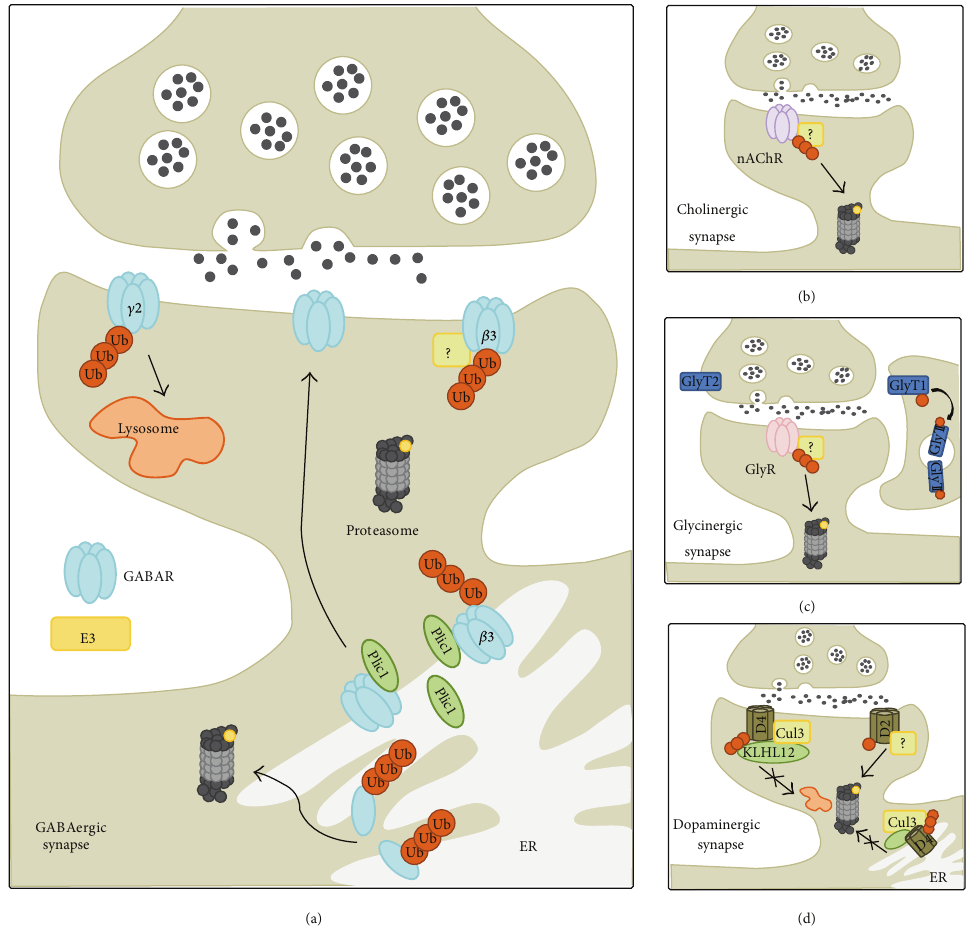
Figure 4: (a) GABAergic ubiquitination. The specific E3 ligase for GABARs has not been identified, although the ubiquitin-like protein Plic- 1, which does not function for ubiquitination, directly interacts with GABA A Rs to affect insertion. It stabilizes polyubiquitinated GABA A Rs in the ER to limit ERAD and promote GABA A R surface expression. Unassembled GABAR subunits in the ER are usually ubiquitinated and targeted to the proteasome. Although the proteasome plays a large role in GABA A R trafficking, the lysosome also mediates GABA A R degradation by ubiquitinating a motif in intracellular domain of the 𝛾 2 subunit. (b) Cholinergic synapses. In the cholinergic synapse, the E3 ligases remain unidentified although it is known that ubiquitination of the 𝛼 3, 𝛽 2, and 𝛽 4 nAChR subunits is required for degradation. (c) Glycinergic synapses. In glycinergic synapses, extensive ubiquitination to the 𝛼 1 subunit of GlyR prior to internalization has been observed in Xenopus oocytes though this has not been repeated in a mammalian system. However, it has recently been shown that the glycine transporter GLYT1 1b subunit undergoes ubiquitination at lysine 619, causing rapid endocytosis. (d) Dopaminergic synapses. In dopaminergic synapses, KLHL12 acts as an adaptor to the E3 ligase Cul3 to promote polyubiquitination of both immature ER-associated and mature membrane- associated forms of the D4 receptor though there is apparently neither proteasomal nor lysosomal degradation observed. The D2 receptor subtype is known to be monoubiquitinated, although possible polyubiquitinated forms may also exist. An E3 ligase has yet to be